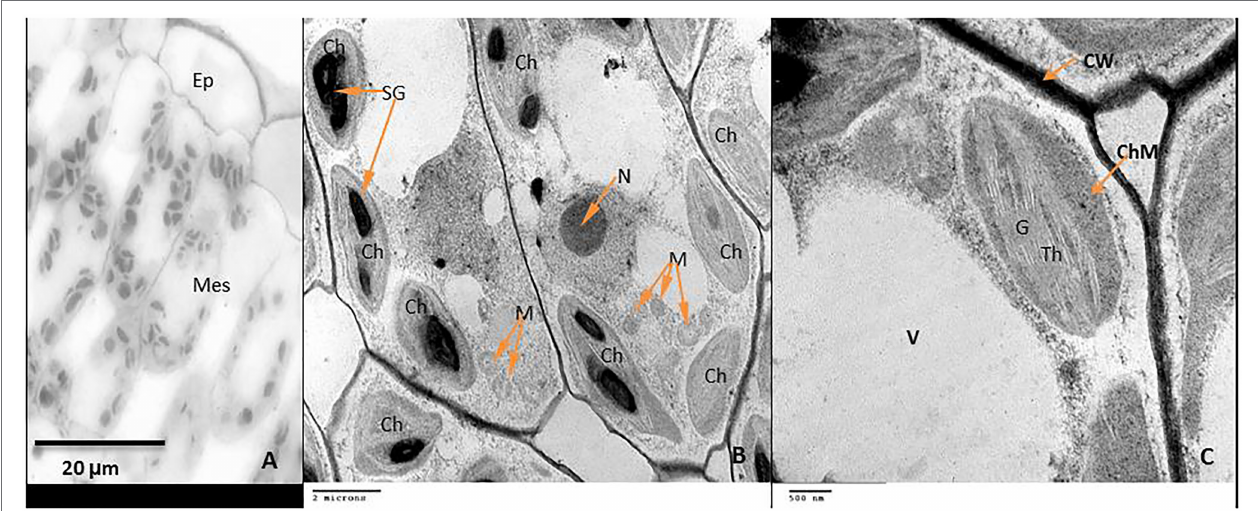
FIGURE 9 | Anatomical structure of Tomato leaf cv “Super marmende” growing under standard condition 25ºC. (A) . Part of leaf cross-section showed the upper epidermis (Ep) and the two mesophyll layers (Mes); note the regular arrangement of chloroplasts. (B) . TEM micrograph showed mesophyll ultra-structures: Mitochondria (M), nucleus (N), chloroplasts (Ch) with elongate shape, and starch grains (SG). (C) . Ultra-structure of one chloroplast showed it has normal envelope or membrane (ChM), well-developed granal lamella (G), and stromal thylakoids (Th), note that the outer cellular membrane was attached well with the cell wall